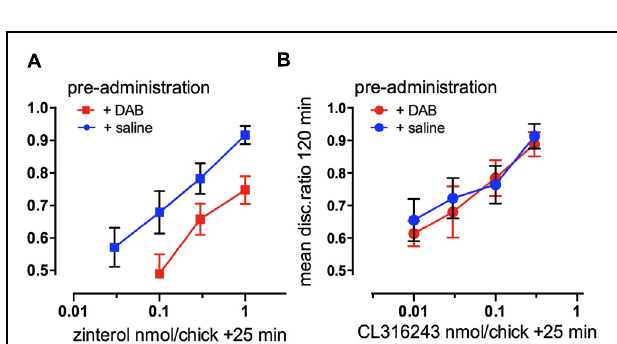
FIGURE 5 | Functional selectivity of drug interaction. (A) Consolidation of memory for weakly reinforced training with the β 2 -AR agonist zinterol or (B) the β 3 -AR agonist CL316243, challenged by preadministration at 20 min of a suboptimal dose of DAB. Zinterol in the presence of DAB, inhibiting the breakdown of glycogen, was less effective in promoting memory consolidation. (From Gibbs et al., 2008c).